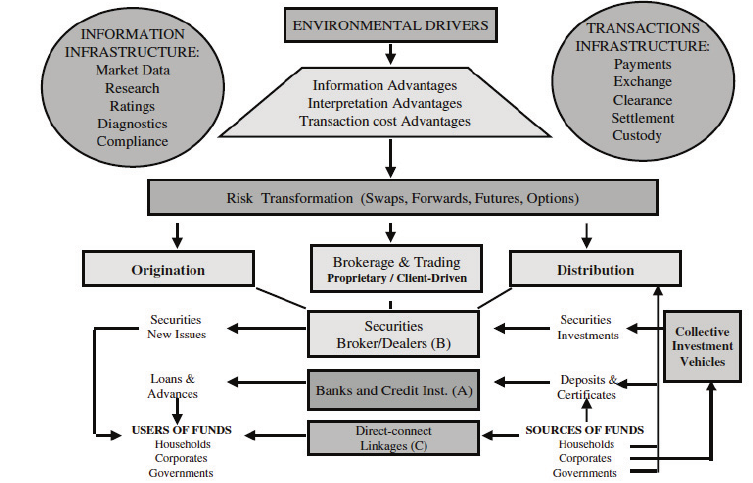
Fig. 1 – Intermediation Dynamics. Source: Choi